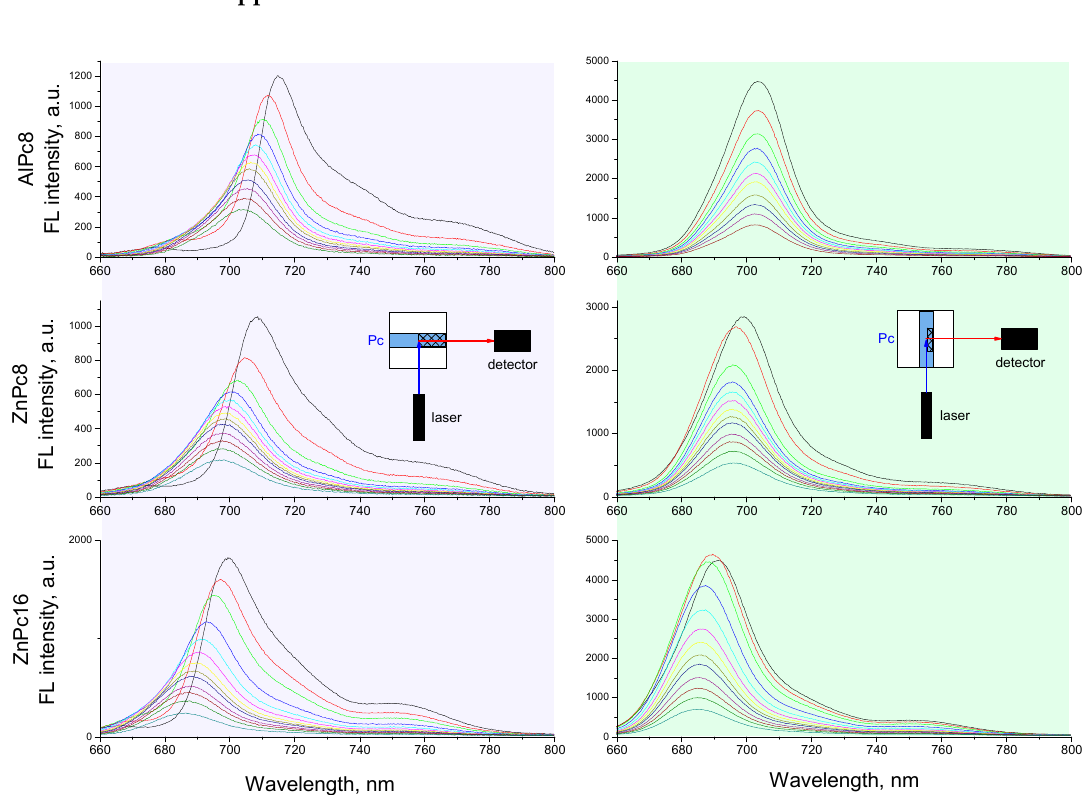
Figure A1. Fluorescence spectra of carboxyphthalocyanines in the concentration range of 1–30 μ M at different positions of the cuvette relative to the fluorescence recording system. The shaded area is where the reabsorption of Pc fluorescence is observed.